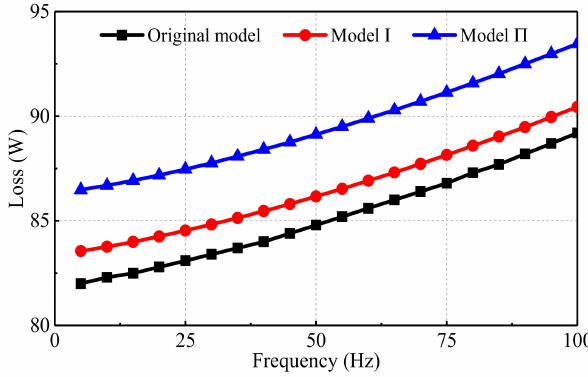
Figure 21. Loss versus frequency.